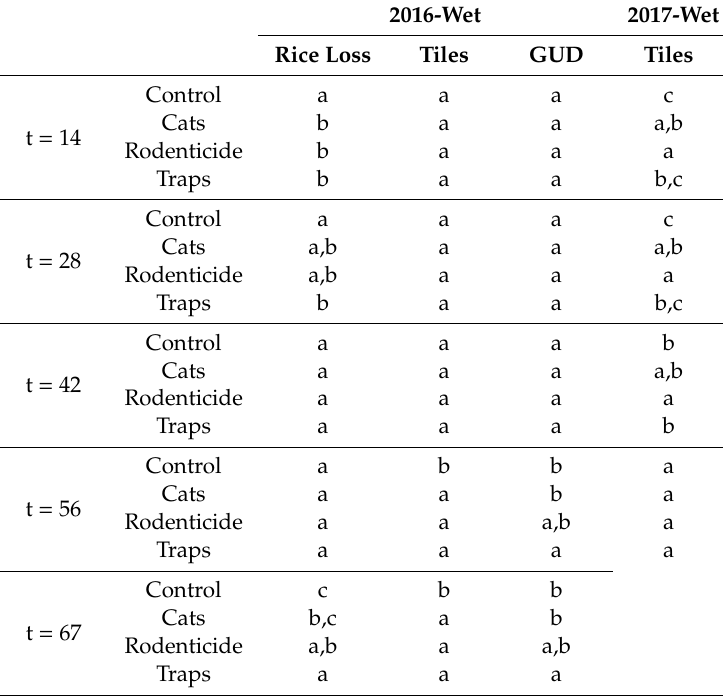
Table 3. Time points (t = days from start of intervention) where comparisons across treatments indicated that some monitoring methods are more likely to point to statistical di ff erences among treatments than others. Pairwise comparisons between the four treatments were made for each timepoint, using the Tukey method with α = 0.05. Values in the same column followed by the same letter are not statistically di ff erent from each